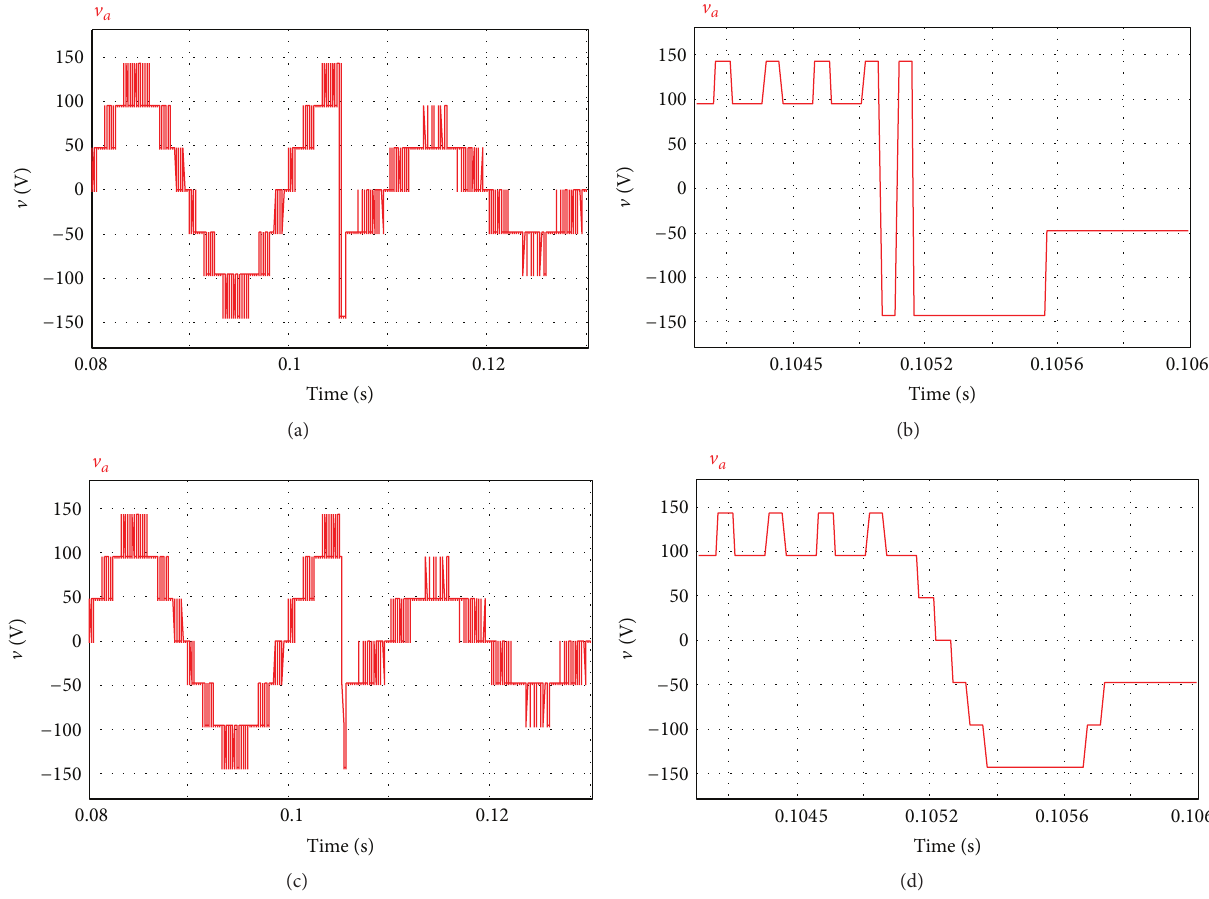
Figure 7: Output voltage for a step change in the reference amplitude. (a) Output voltage with conventional FS-MPC. (b) Detail of the reference step change showing the output voltage with conventional FS-MPC. (c) Output voltage with simplified FS-MPC. (d) Detail of the reference step change showing the output voltage with simplified